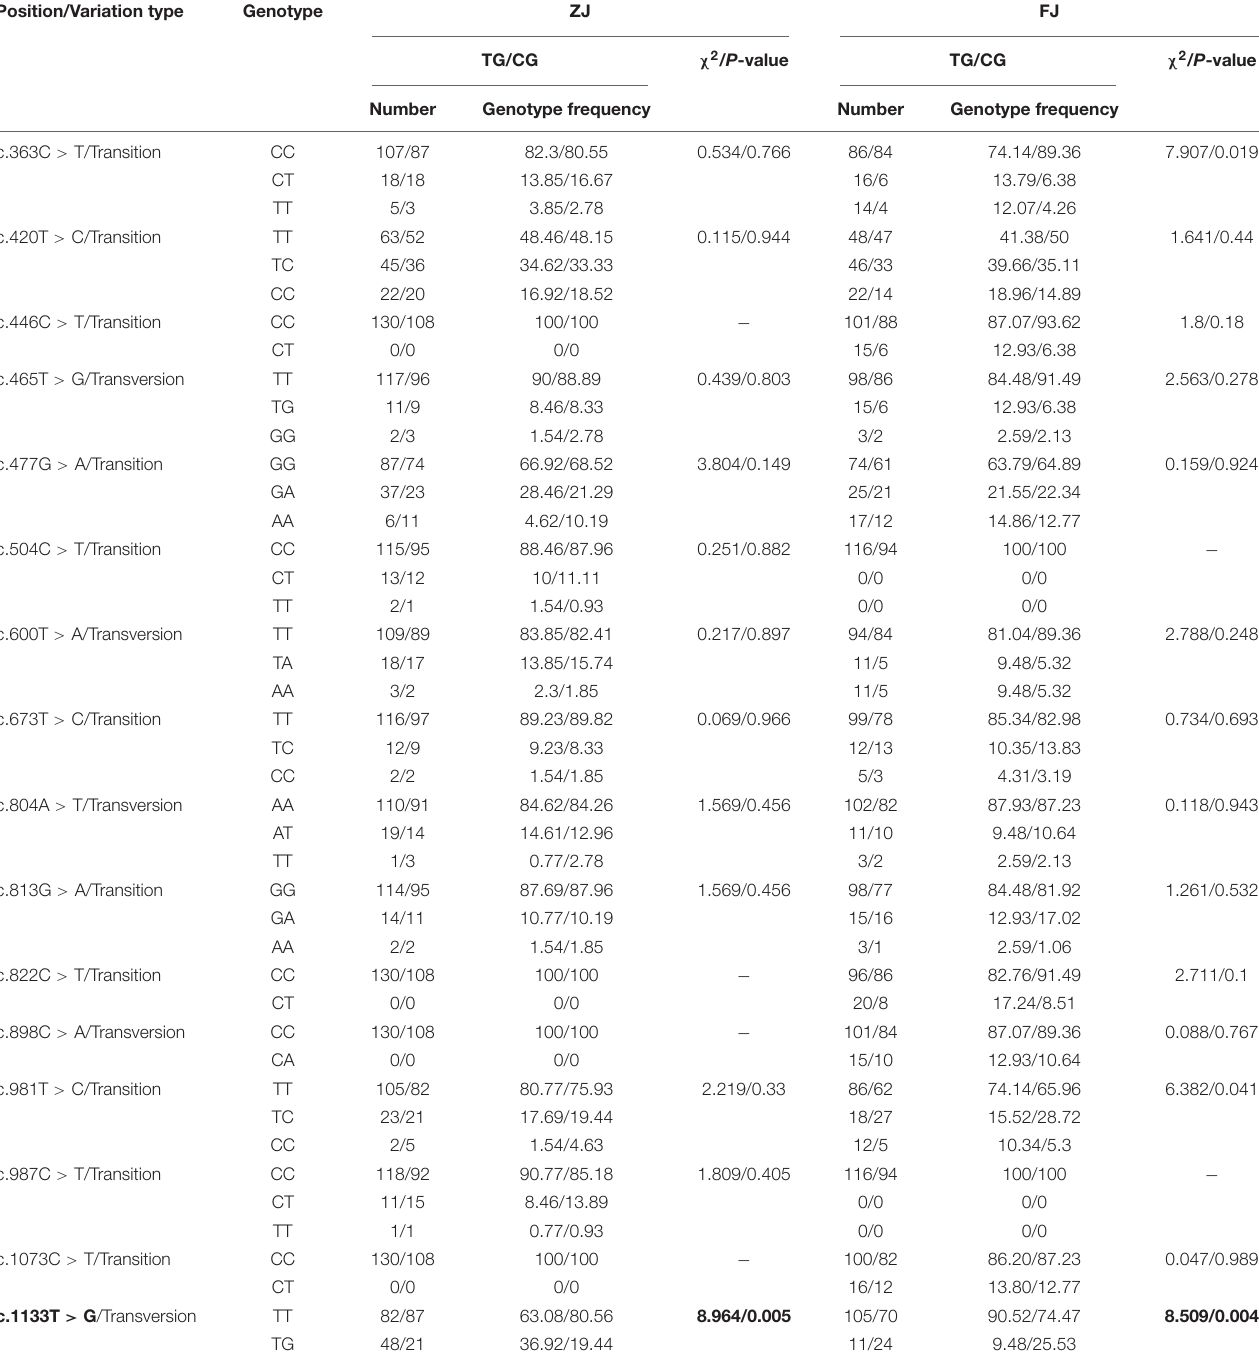
TABLE 2 | Genotype, variation type, and gene frequency of single nucleotide polymorphisms (SNPs) in Glutamine synthetase gene from Sinonovacula constricta ( Sc-GS ). Position/Variation